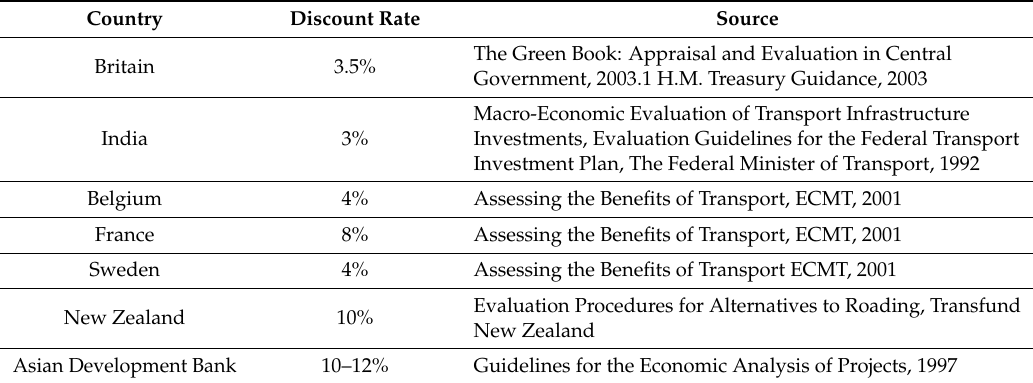
Table 7. Discount rates used in benefit/cost analyses of public projects (MLTT, 2004)